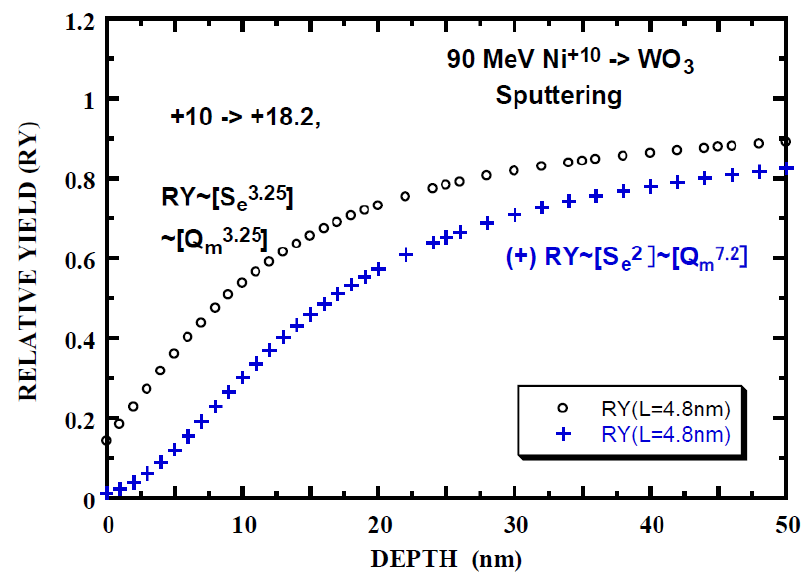
Figure 6. Depth dependence of relative yield (RY) of electronic sputtering of WO 3 films irradiated by 90 MeV Ni +10 . Open circles (o) and crosses (+) indicate RY calculated with nk = 3.25 (n = 3.25, k = 1) and nk = 7.2 (n = 3.6, k = 2), respectively, (integrand of Equation (3b) is indicated by [ ]). Mean-charge evolution calculated by Equation (2a) with L = 4.8 nm, Q o = 10 and Q eq = 18.2.